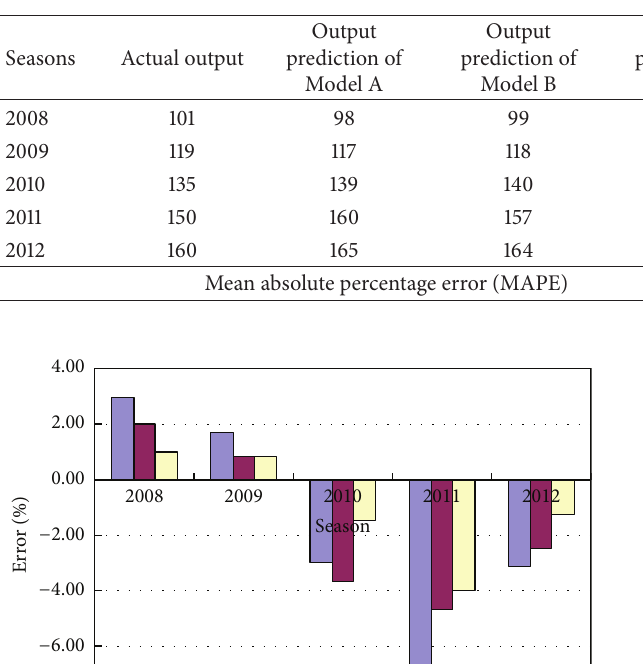
Table 9: Comparison of output predictions and actual output.